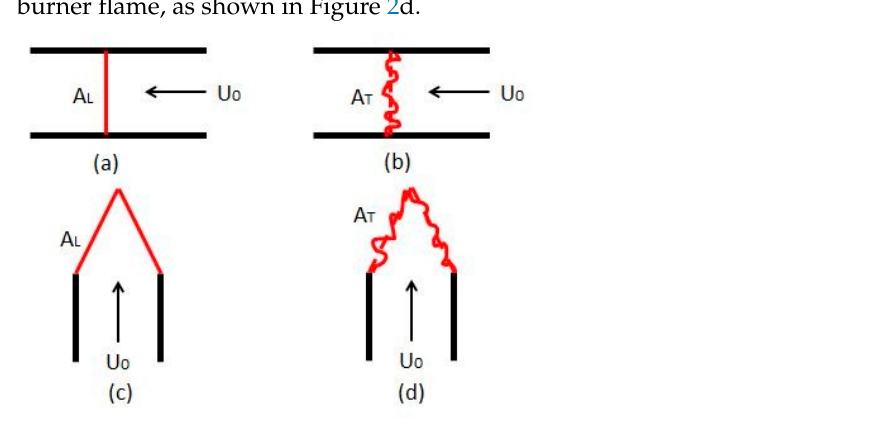
where S T represents the turbulent flame velocity, U 0 represents the jet exit velocity, A 0 repre- sents the jet exit area, and A T represents the average front surface area of the turbulent flame. Figure 4a presents a typical OH-PLIF instantaneous flame image of an operation condition. The instantaneous front surface structure of the flame can be extracted from the OH-PLIF instantaneous flame image (Figure 4a), and the flame front (Figure 4b) can be achieved distinctly with the adaptive threshold method. First, the background signal was subtracted and the effect of the uneven distribution of laser energy was removed from the original image using MATLAB. Second, the spot was assigned to 1 when the intensity of the OH fluorescence signal was more than 0, or the spot was assigned to